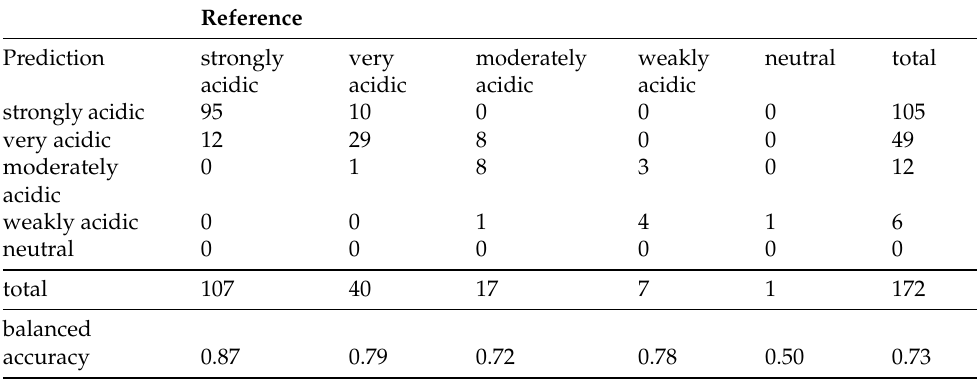
Table 5. Error matrix of predicted and observed